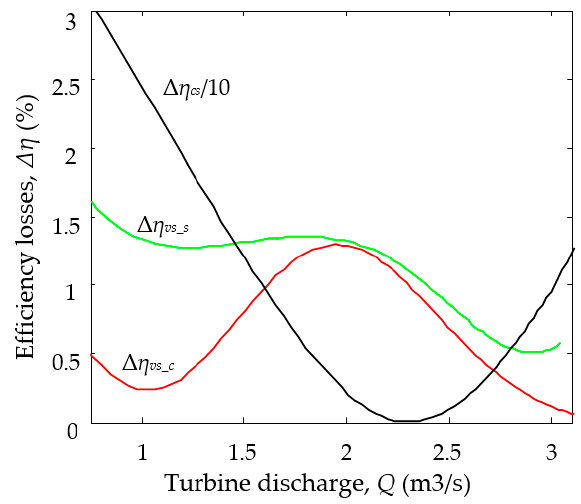
Figure 12. Turbine e ffi ciency losses as a function of discharge for the simplified formula (solid green line), the corrected formula (solid red line) and the constant speed curve (solid black line) divided by 10.